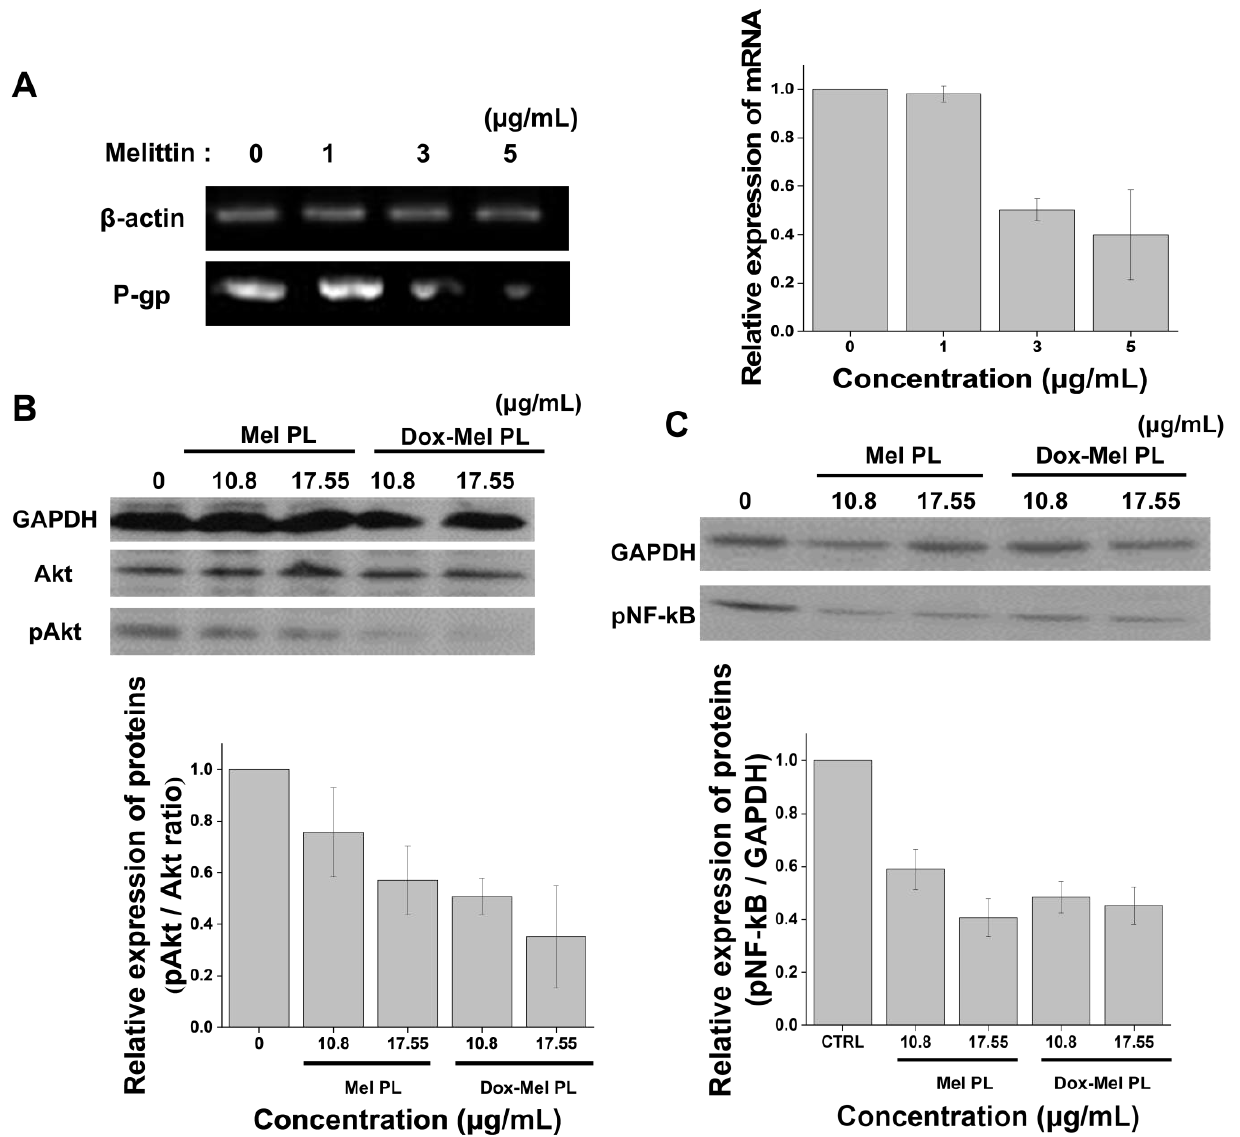
Figure 4. Confirmation of the expression of the efflux pump receptor in MCF-7/ADR cells. ( A ) Semi-quantitative mRNA expression of P-gp in MCF-7/ADR cells through reverse transcriptase RT-PCR. The indicated concentration is based on the melittin concentration. Western blot analysis of the protein expression levels of Akt, ( B ) pAkt, and ( C ) pNF- κ B. GAPDH was used as the loading control. The bar charts represent the quantitative comparisons between the groups. The indicated concentration is also based on the melittin concentration. Bar graphs show the mean values calculated from three experiments.